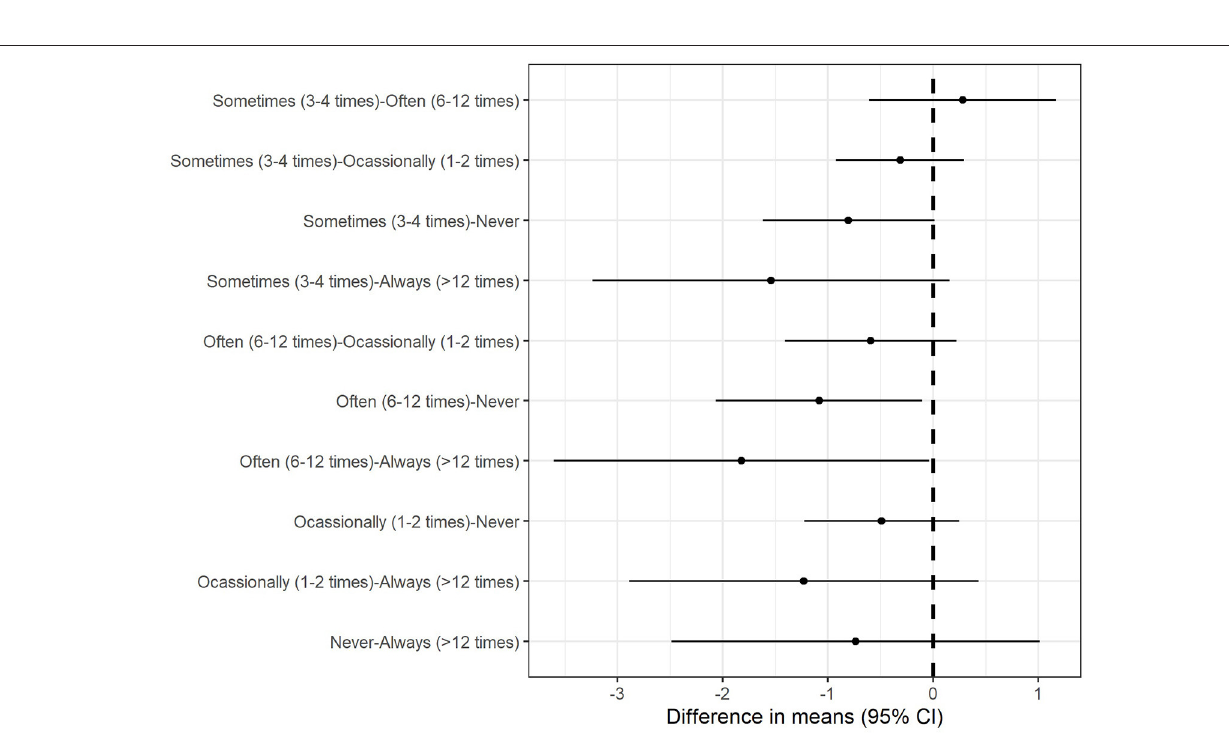
Frontiers in Public Health |